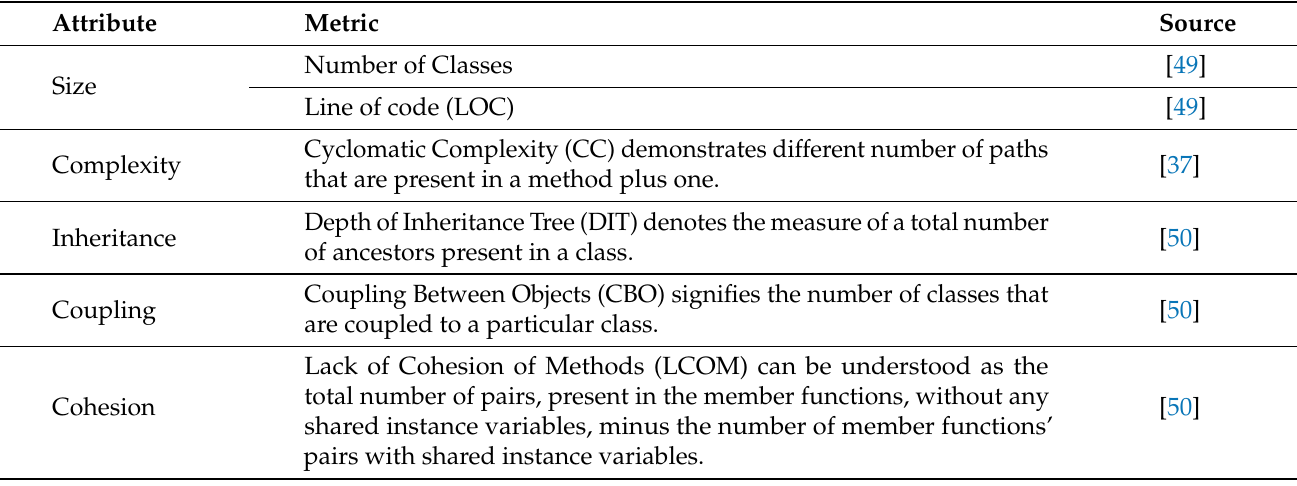
Table 1. Software Internal Quality Metrics and